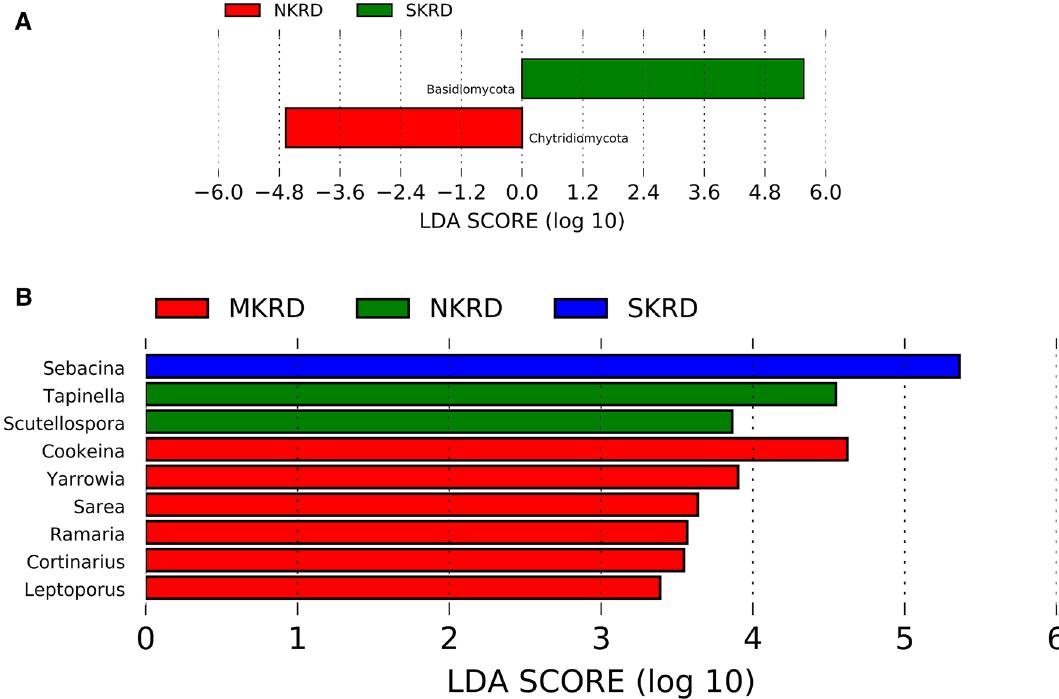
Figure 2. The Linear discriminant analysis (LDA) Effect Size (LEfSe) analysis was used to identify phylum ( A ) and genus ( B ) that respond significantly to karst rocky desertification progression. Relative abundance is